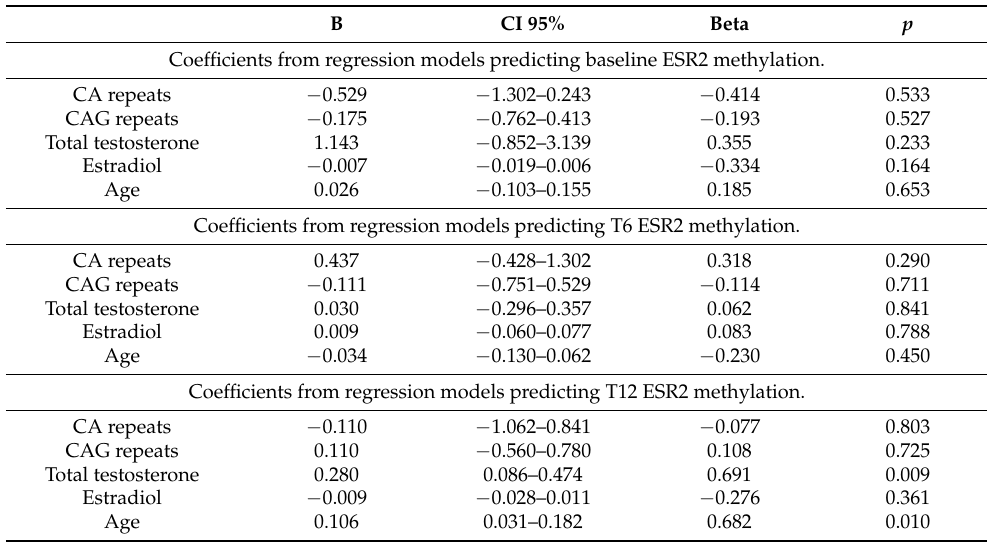
Table 4. Coefficients from regression models predicting baseline ESR2 methylation.